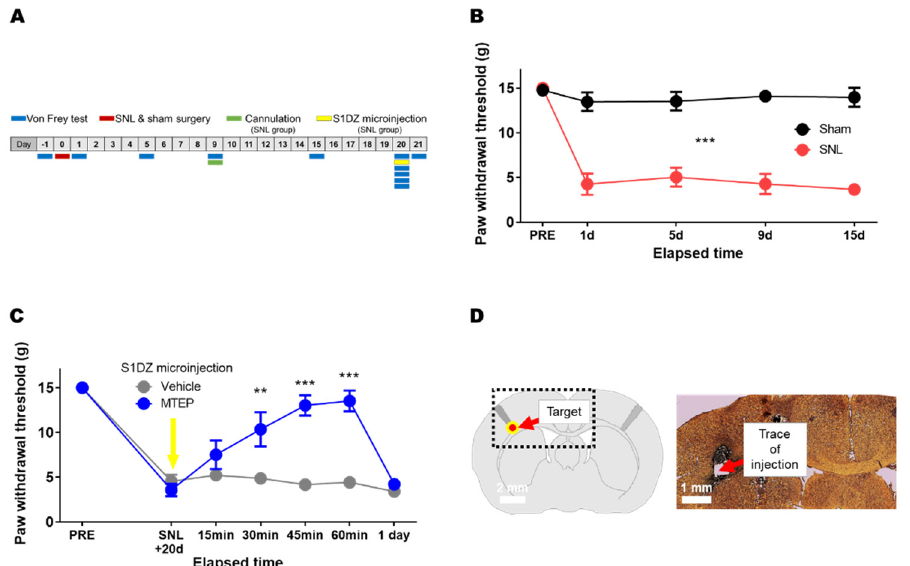
Figure 2. Microinjection of the mGluR5 antagonist into the S1DZ ameliorated SNL-induced mechani- cal allodynia. ( A ) Experimental design. ( B ) SNL group showed a reduction in the paw withdrawal threshold in the von Frey test, indicating mechanical allodynia (*** p < 0.001; two-way repeated- measures ANOVA; sham n = 12, SNL n = 11). ( C ) Microinjection of mGluR5 antagonist MTEP into the S1DZ ameliorated neuropathic mechanical allodynia symptom of SNL group (** p < 0.01, *** p < 0.001; two-way repeated-measures ANOVA with Bonferroni’s test; vehicle n = 5, MTEP n = 6). ( D ) Verification of cannula trajectory.